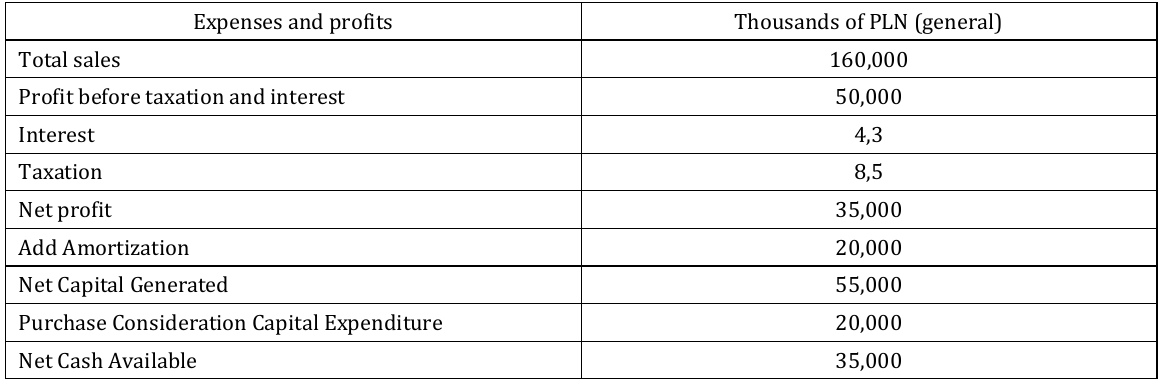
Table 1. Economical analysis of the coal-mining waste dump `X` in USCB (source: Gawor, 2014 after Analysis of Ipas Polska sp. z o.o.,